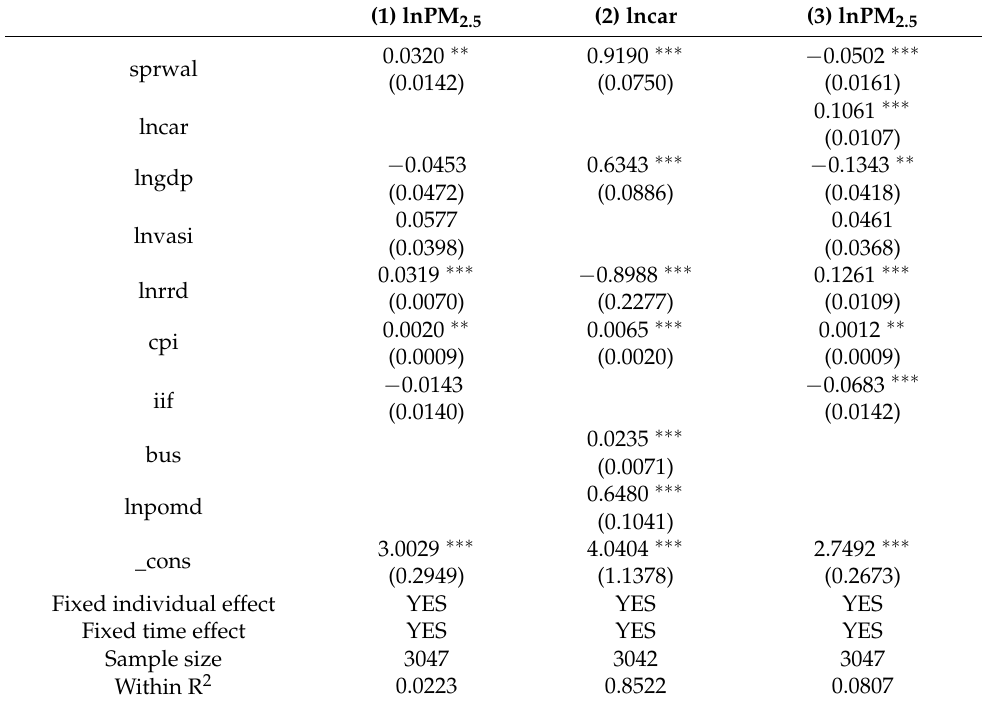
Table 2. Empirical results of model 1, model 2 and model